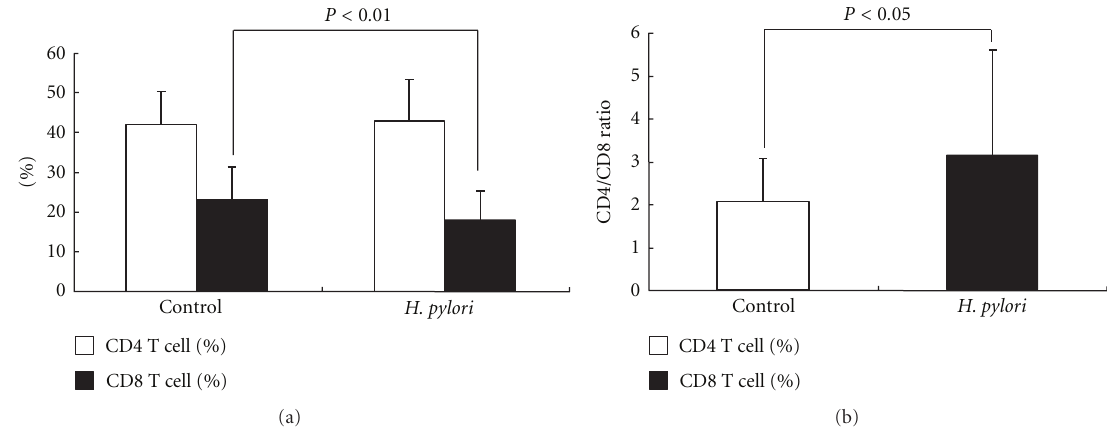
Figure 1: (a) Comparison of the percentage of CD4 + and CD8 + T cells. Left and right sides show the data of control subjects and H. pylori- infected patients, respectively. White columns represent the percentage of CD4 + T lymphocyte, and black columns represent CD8 + T lymphocyte. Data are given as mean ± SD. There was no significant di ff erence in the percentage of CD4 + T cells in H. pylori -infected patients (mean ± SD; 43 . 0 ± 10 . 4%) as compared to control subjects (mean ± SD; 42 . 2 ± 8 . 1%). However, the percentage of CD8 + T cells was significantly lower in H. pylori- infected patients (mean ± SD; 18 . 0 ± 7 . 1%) compared to control subjects (mean ± SD; 23 . 2 ± 7 . 8%) ( P < 0 . 05). (b) CD4/CD8 ratio in control subjects (white column) and H. pylori- infected patients (black column). Data are given as mean ± SD. The CD4/CD8 ratio was significantly higher in H. pylori -infected patients (mean ± SD; 3 . 1 ± 2 . 4) compared to control subjects (mean ± SD; 2 . 1 ± 1 . 0) ( P < 0 .